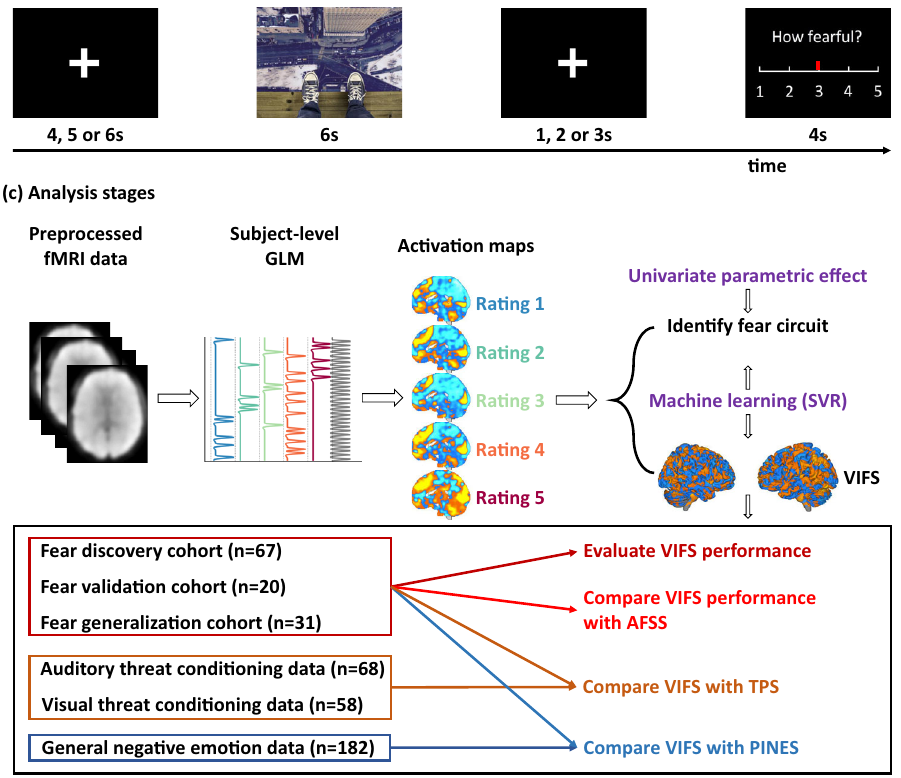
Fig. 1 Experimental paradigms and analysis stages. Discovery ( a ) and validation ( b ) cohorts underwent two similar but not identical fear induction and rating paradigms during fMRI acquisition. Of note, examples of the fear-evoking photos are pictures only for display purposes and not included in the original stimulus set. The pictures have been obtained from pixabay.com under the Pixabay License, and are free for commercial and noncommercial use across print and digital. c depicts the analytic stages and datasets used in the present study. Speci fi cally, a whole-brain multivariate pattern